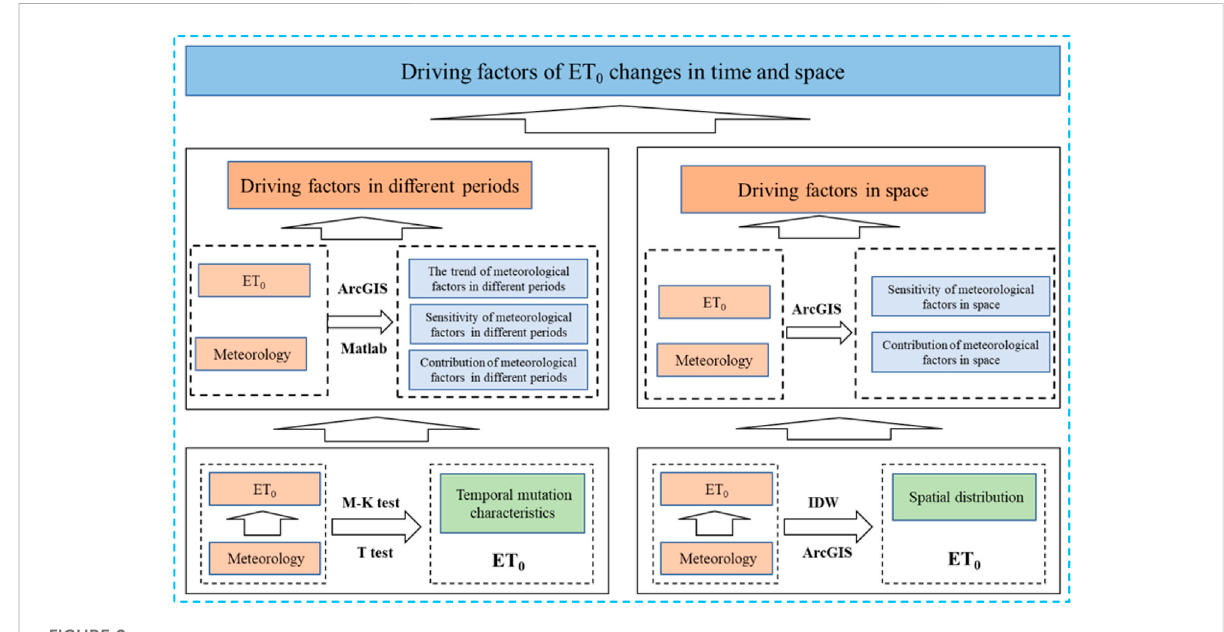
Work fl ow of this